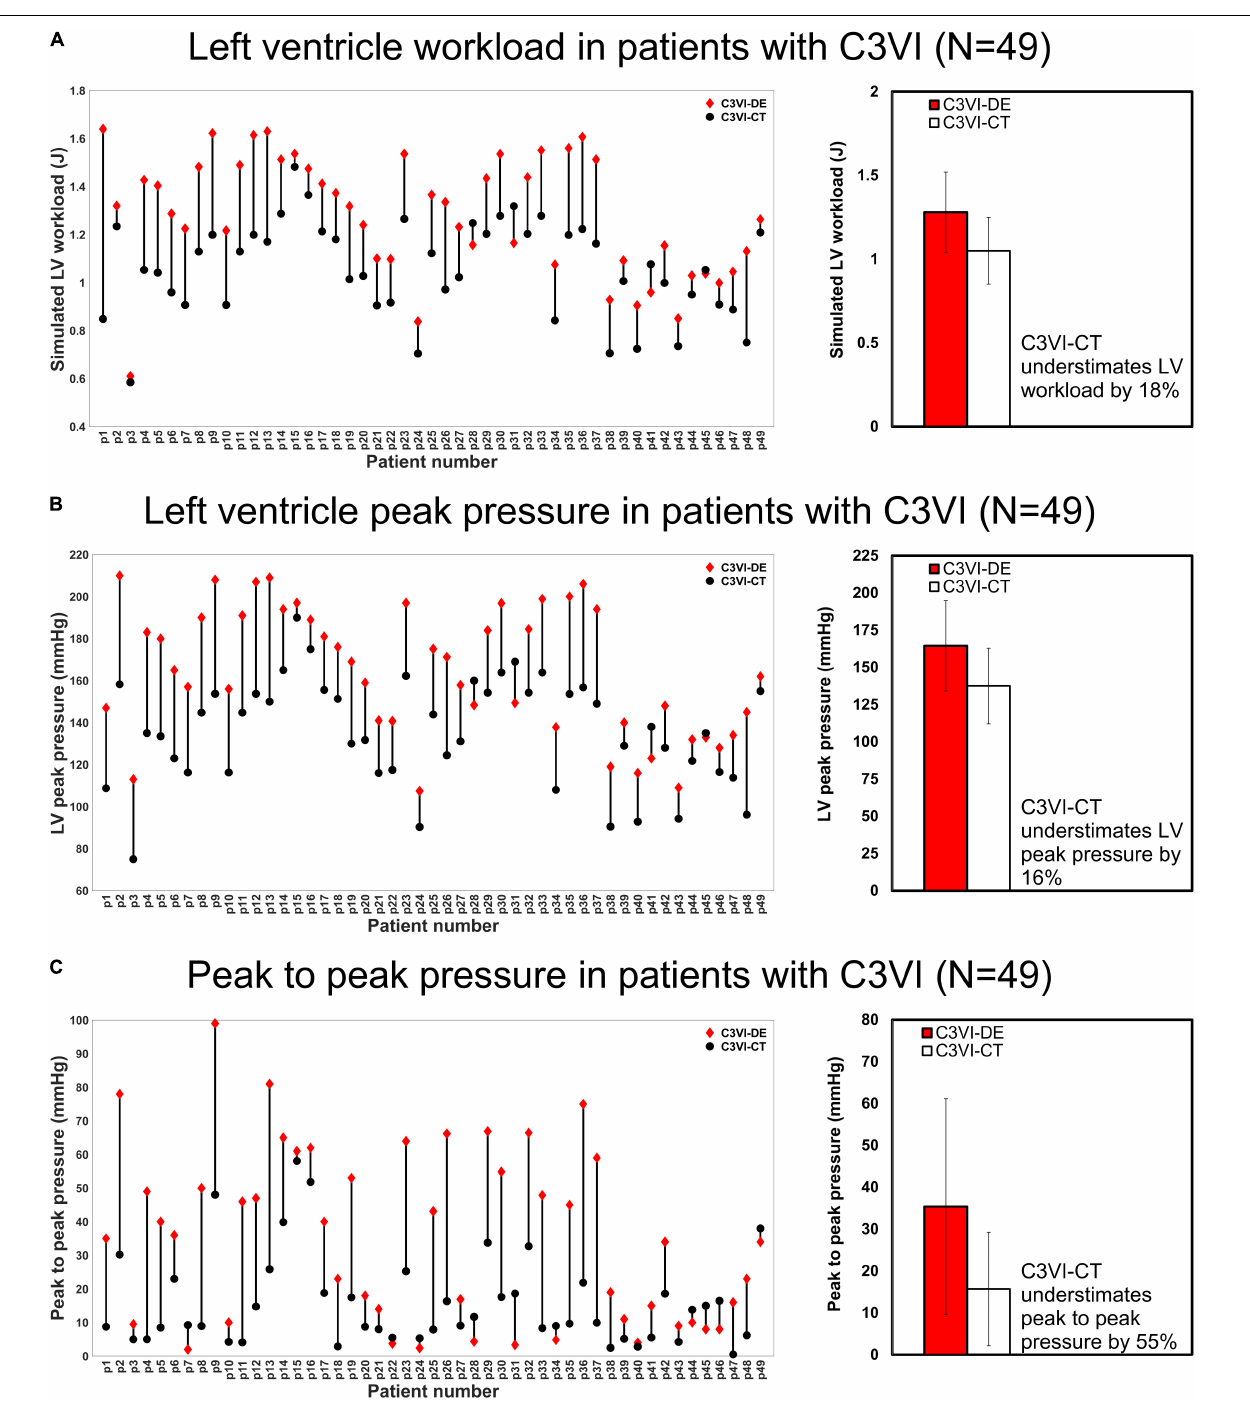
FIGURE 6 | Changes in hemodynamics assessments calculated by C3VI-DE and C3VI-CT in patients with C3VI ( N = 49). (A) LV workload; (B) LV peak pressure; (C) Peak to peak pressure. Two-sample t -test showed that calculations of C3VI-DE and C3VI-CT for all three variables (LV workload, LV peak pressure and peak to peak pressure) are significantly different at 0.01 significance